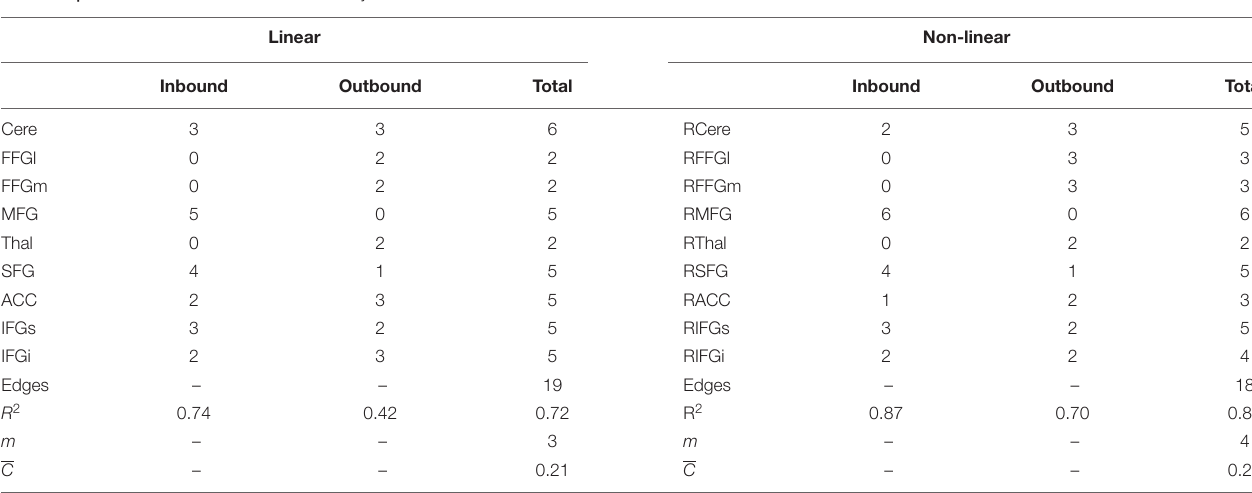
TABLE 3 | Results of the network structure